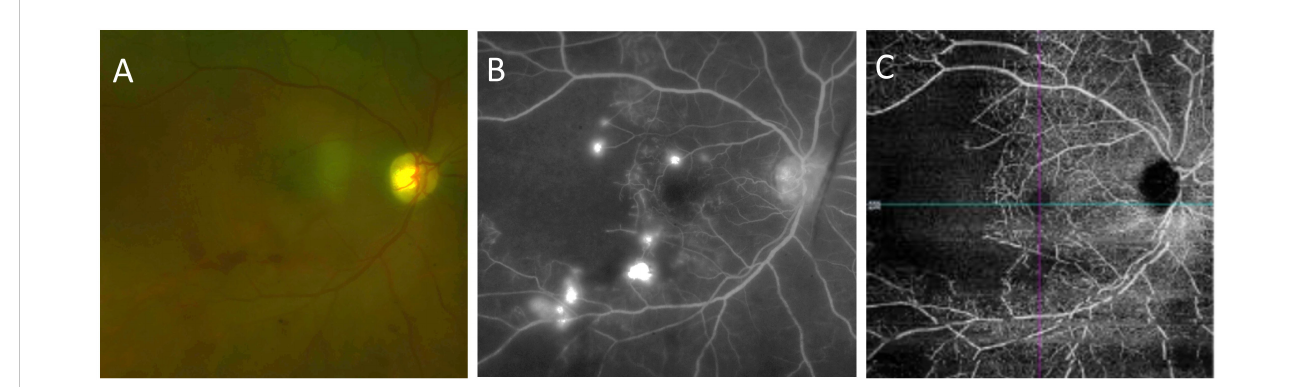
FIGURE 3 Case number 7. Multimodal imaging of a 48-year-old female with polyarthralgias, diffuse alopecia, ulceration of the hard palate, dyspnea, proteinuria subsequently diagnosed as class-III lupus nephritis, hypergammaglobulinemia and positive anti-Smith antibodies that presented to the ED with acute onset vision loss of the right eye following a biopsy of an axillary lymph node that demonstrated mixed lympho-plasmocytic proliferation compatible with fl orid systemic lupus. She had been on IV CYC, and oral MMF prior to the ophthalmic manifestations. (A) Fundus photograph shows macular ischemia with inferior hemorrhage and pale looking retina. (B) Late phase FA shows multiple pinpoint areas of leakage with a large area of nonperfusion temporally. (C) OCTA clearly shows lack of blood fl ow temporal to the fovea. Due the severe retinal ischemia the patient was treated with 1000 mg IV